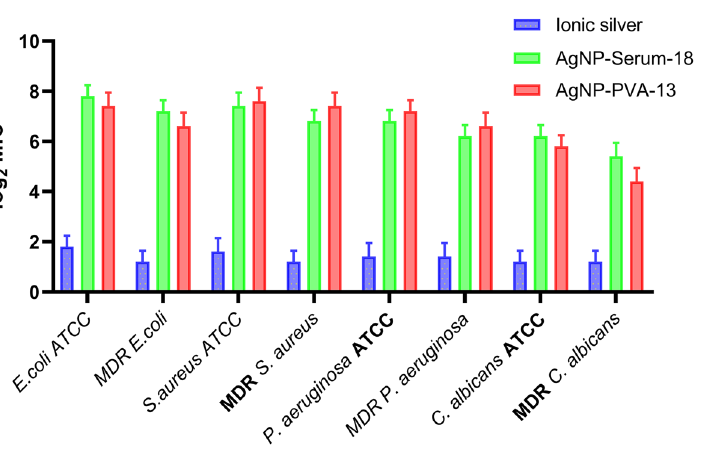
Figure 2. Physical characterization of AgNP-PVA-13. ( A ) UV–Vis absorption spectra of AgNP-PVA-13. ( B ) Cluster size obtained from DLS measurements. ( C ) Zeta potential of AgNP-PVA-13. ( D ) TEM image.